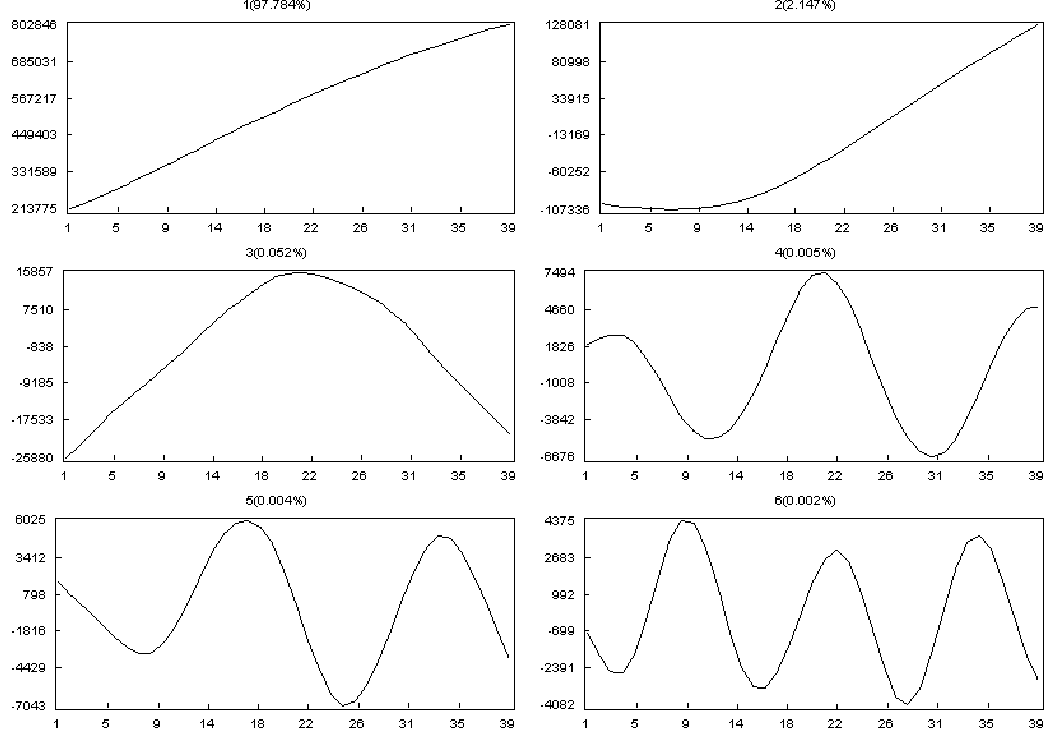
Figure 8. Matrix of w-correlations for the 38 reconstructed components.